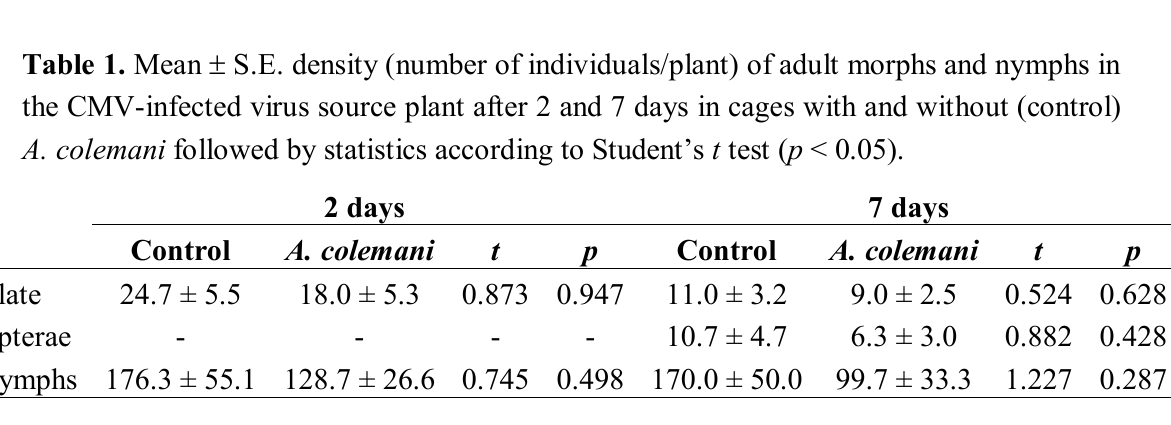
Figure 1. Mean ± S.E. values of total number of aphids on test plants in cages with (grey bars) and without (control cages, white bars) A. colemani . ( a ) CMV-infected source plant assay at 2 days. ( b ) CMV-infected source plant assay at 7 days. ( c )